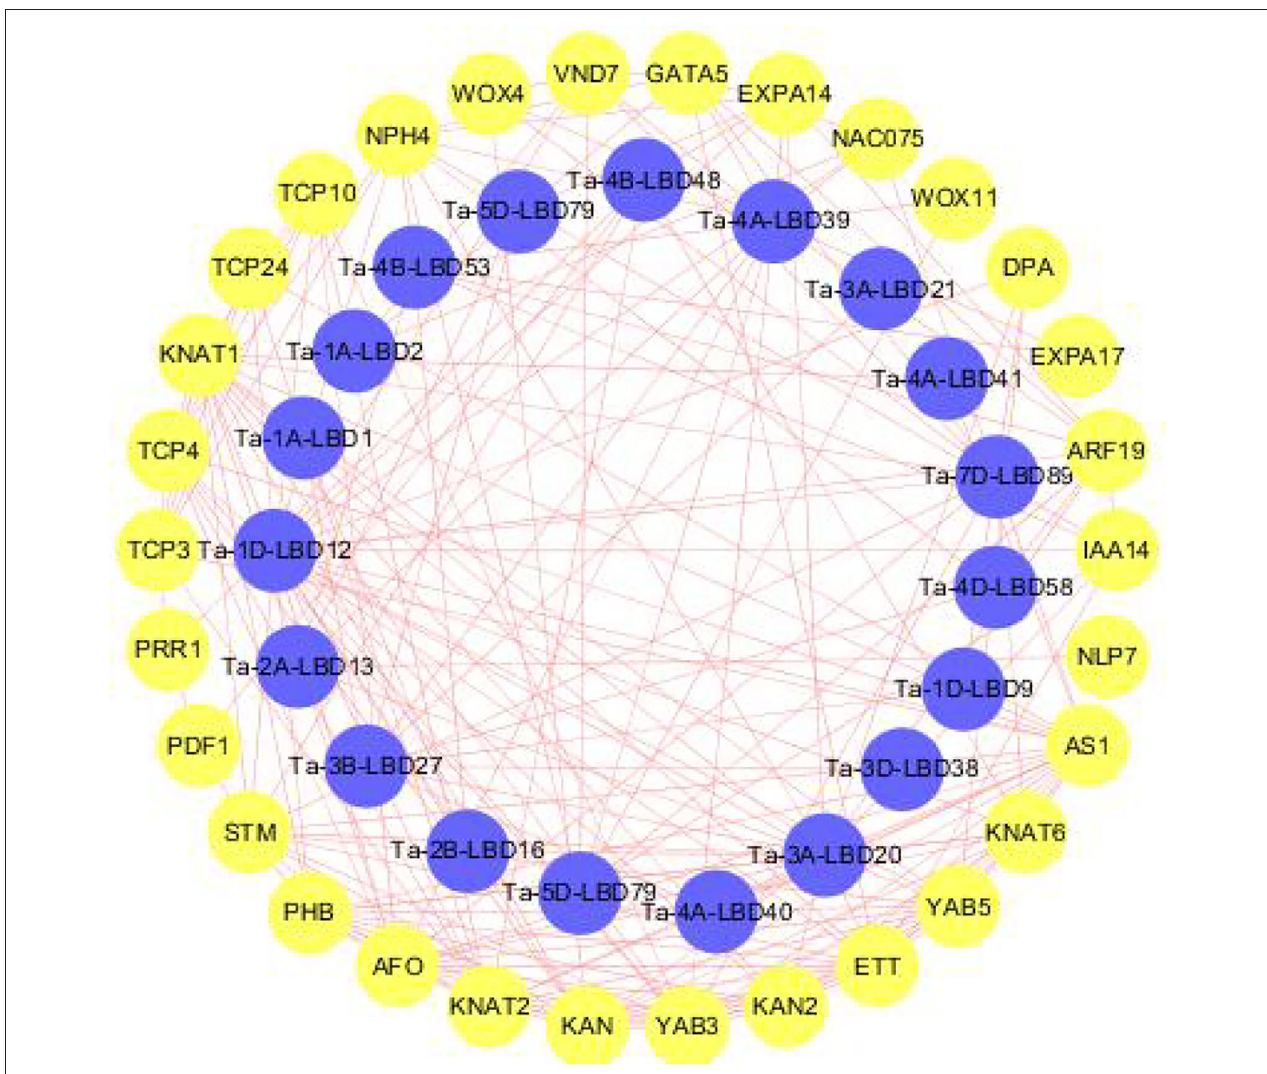
FIGURE 5 | Predicted protein-protein interaction networks of TaLBD proteins with other wheat proteins using STRING tool. The blue circles represent wheat LBD proteins, and the circles on the outside represent proteins that interact with TaLBDs. The two circles connected by the red line represent the interaction between the proteins. LBD: lateral organ boundaries domain, TaLBDs, wheat lateral organ boundaries domain